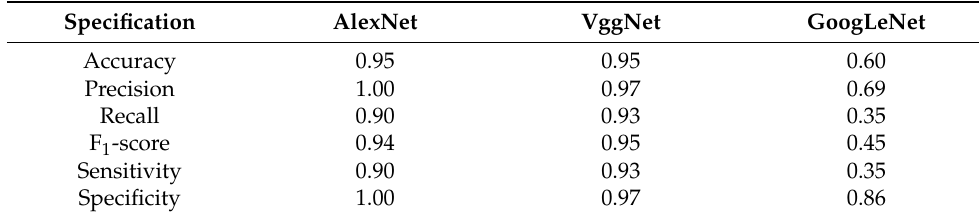
Table 2. Metric comparison under different illuminations.